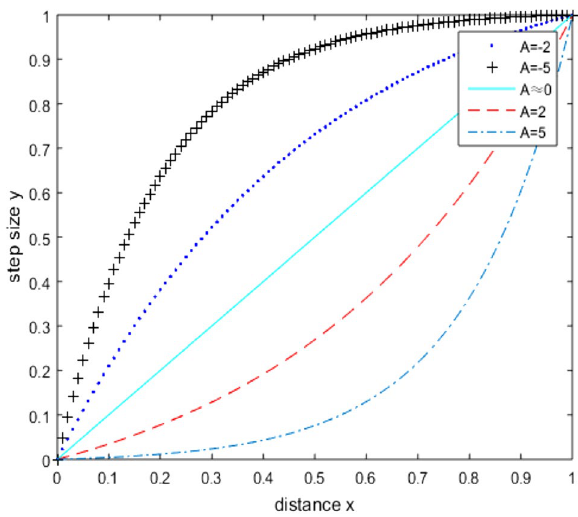
Figure 12. Relation between distance and mesh size.